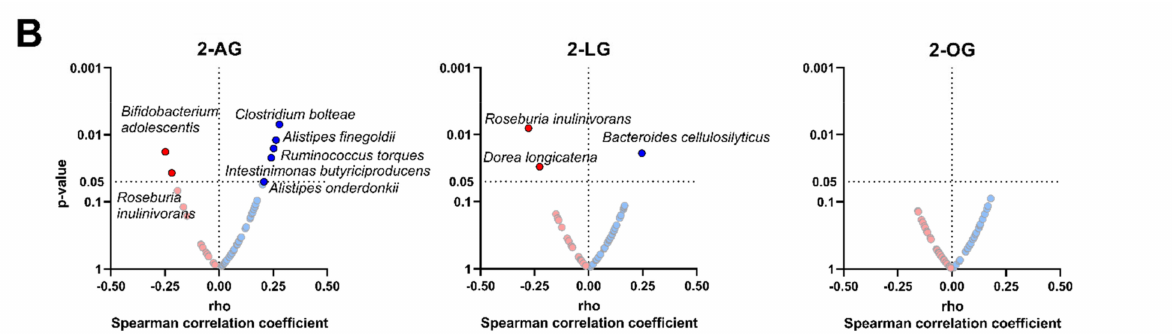
Figure 3. Volcano plots showing partial Spearman correlations of plasma levels of endocannabi- noids and their analogues with the relative abundance of certain bacterial species. Each volcano plot shows the rho coefficients in the X-axis, and p -values of the correlations are shown on the Y-axis. Panel ( A ) shows AEA and related N-acylethanolamines, whereas panel ( B ) shows 2-AG and related acylglycerols. Red circles indicate negative correlations, whereas blue circles indi- cate positive correlations. Body mass index was included as a confounder in these correlations. Only those bacterial species with significant p -values ( p < 0.05) are annotated within the